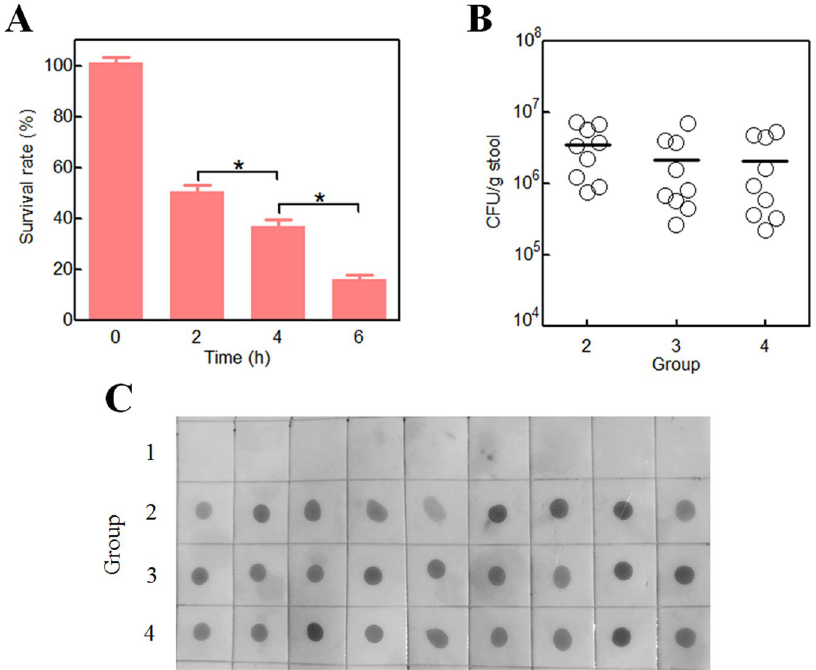
Figure 4. Persistence of surface-engineered E . coli in the murine gastrointestinal system. Incubation of surface engineered E . coli in SGJ, and bacterial survival was assayed at certain time intervals ( A ). * A significant difference (One-way ANOVA statistical analysis, P < 0.001). Bacterial density in large intestinal contents in mice after receiving Lpp-OmpA displayed E . coli (group 2), saturatedly leaded PbrR-displayed E . coli (group 3), unsaturatedly leaded PbrR-displayed E . coli (group 4) for 15 d ( B ). At day 15, the stool samples in four groups were all obtained. The stool samples in groups 2, 3, and 4 were cultured on LB agar with ampicillin (50 μ g/mL) and chloramphenicol (34 μ g/mL). Then, the intestinal recombinant bacterial concentration was calculated and indicated as the number of CFU per gram of gut contents (CFU/g stool). Each circle represents one mouse (n = 9), and the bars indicated median CFU values. Stool samples from all four groups were picked. Crude bacterial extracts were separated from the stool samples and dripped on PVDF membrane after cell lysis, and standard Western blot process was done using anti-His IgG as primary antibody to detect the recombinant Lpp- OmpA (Group 2) or Lpp-OmpA-PbrR (Group 3 and 4) ( C ).